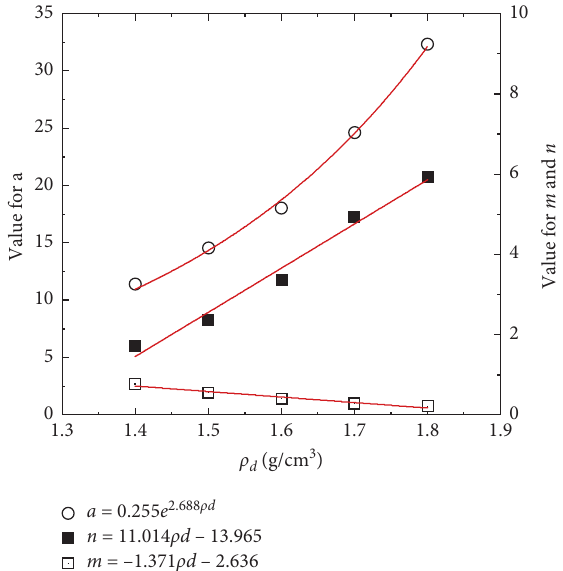
Figure 9: Relationship between a , n , and m and initial dry density.